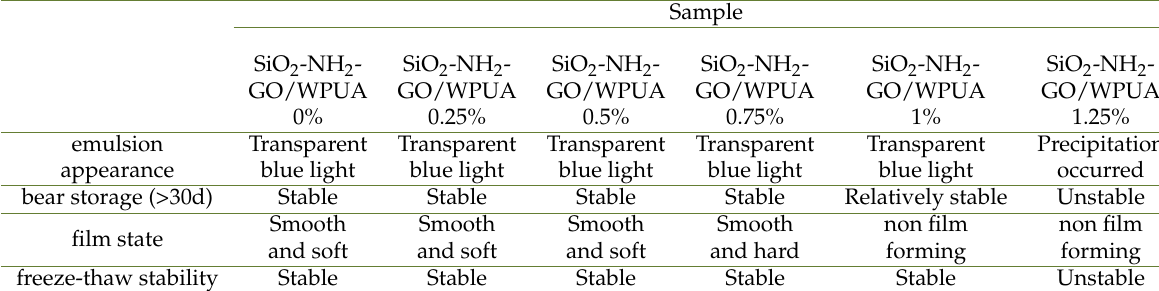
Table 1. The stability of the SiO 2 -NH 2 -GO/WPUA